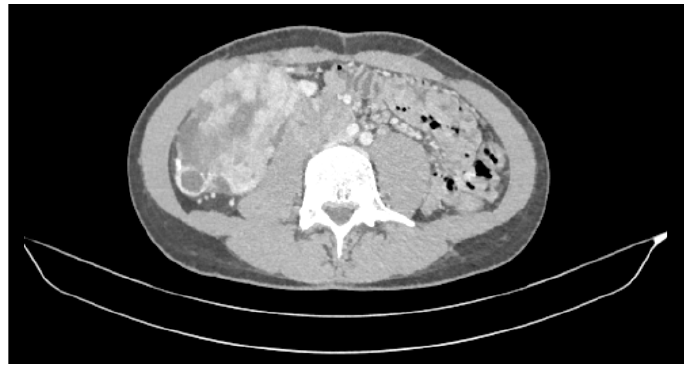
Figure 1. CT at diagnosis. Mass at the upper pole of the right kidney .